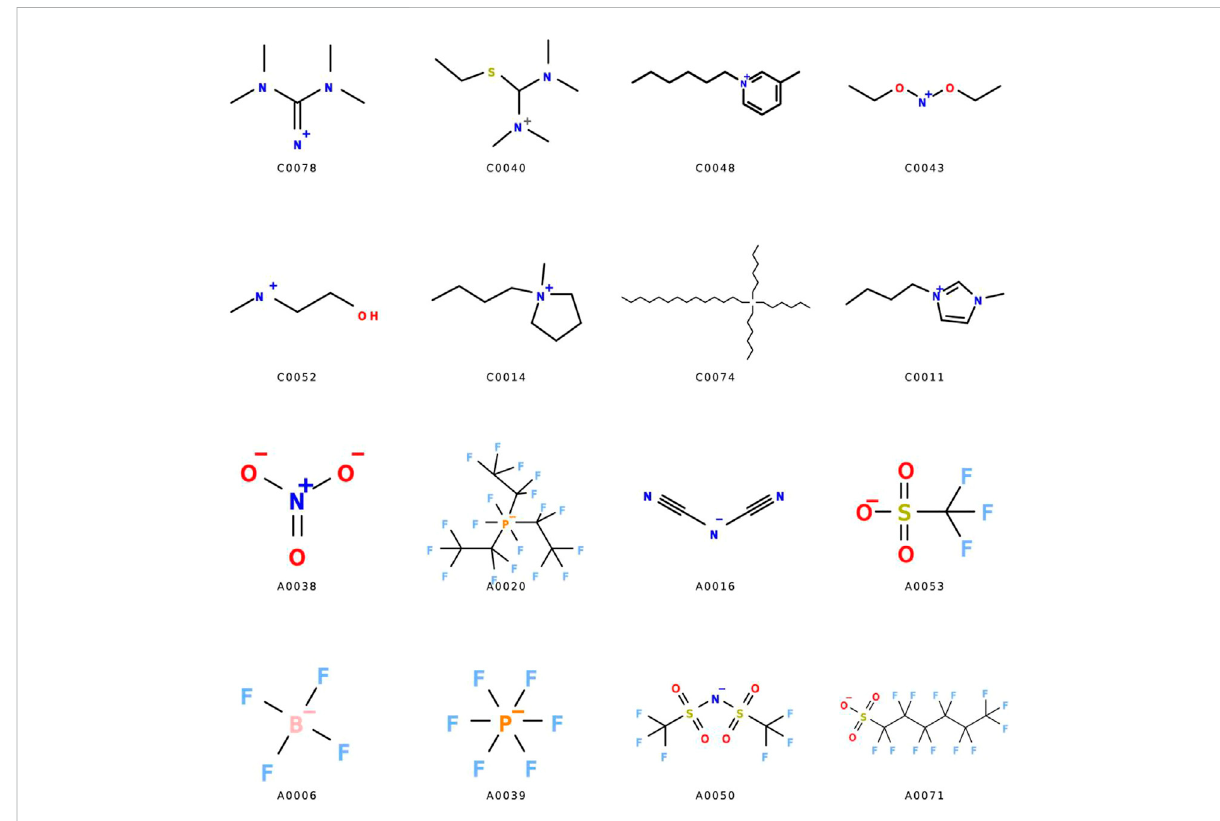
FIGURE 10 Prominent cations (pre fi xed with “ C ” ) and anions (pre fi xed with “ A ” ) found in the dataset (Venkatraman and Alsberg,